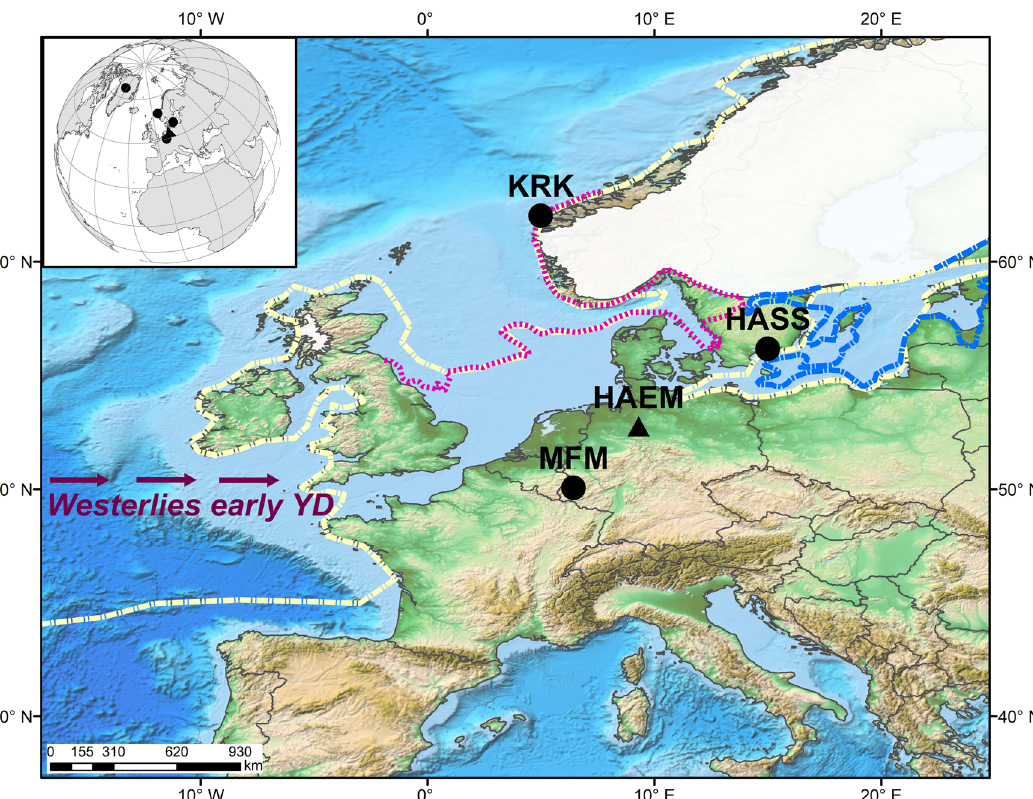
Fig. 1 YD palaeogeographic setting of northwest Europe. Hämelsee (triangle; HAEM) and other high-resolution palynological sites (circles; Kråkenes (KRK), Hässeldala Port (HASS), Meerfelder Maar (MFM)) are located on a N-S transect across northwest Europe. The maximum extent of the YD Scandinavian Ice sheet (white), the YD coastline of the North Sea (red line), the Baltic Ice Lake (blue line), and the winter sea ice extent (yellow line) are also shown 13,73